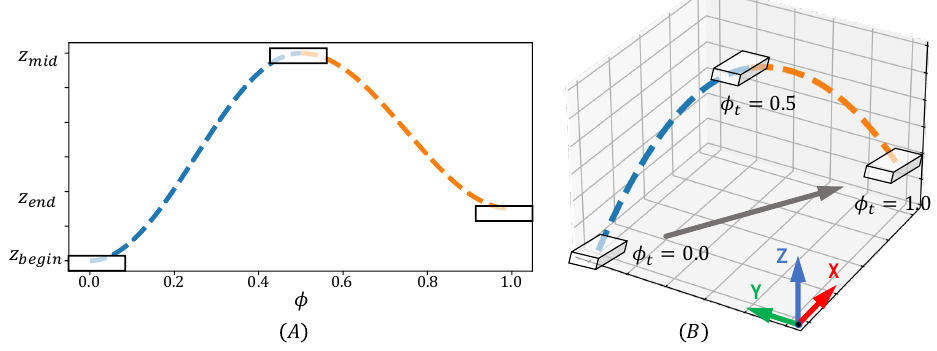
Figure 4. Planned Foot Swinging Trajectory. ( A ) is the plot of phase value and Z axis position of swing foot. White rectangle demonstrates the target position of foot under specific phase value φ . ( B ) shows the 3-D curve of the planned spatial